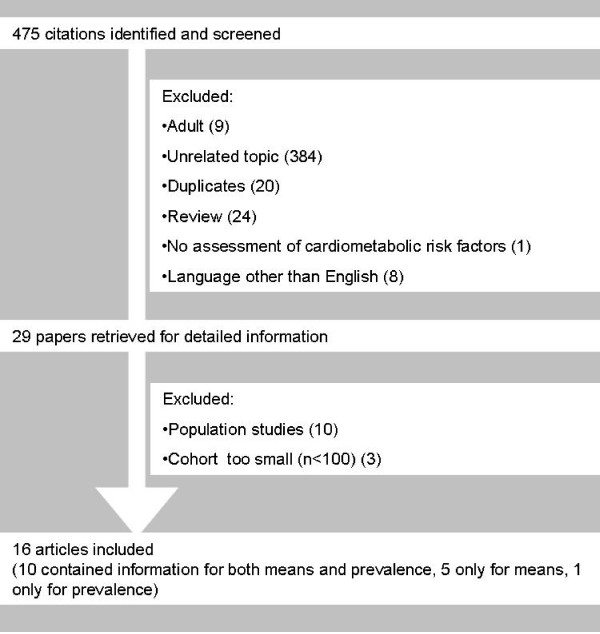
Literature search.